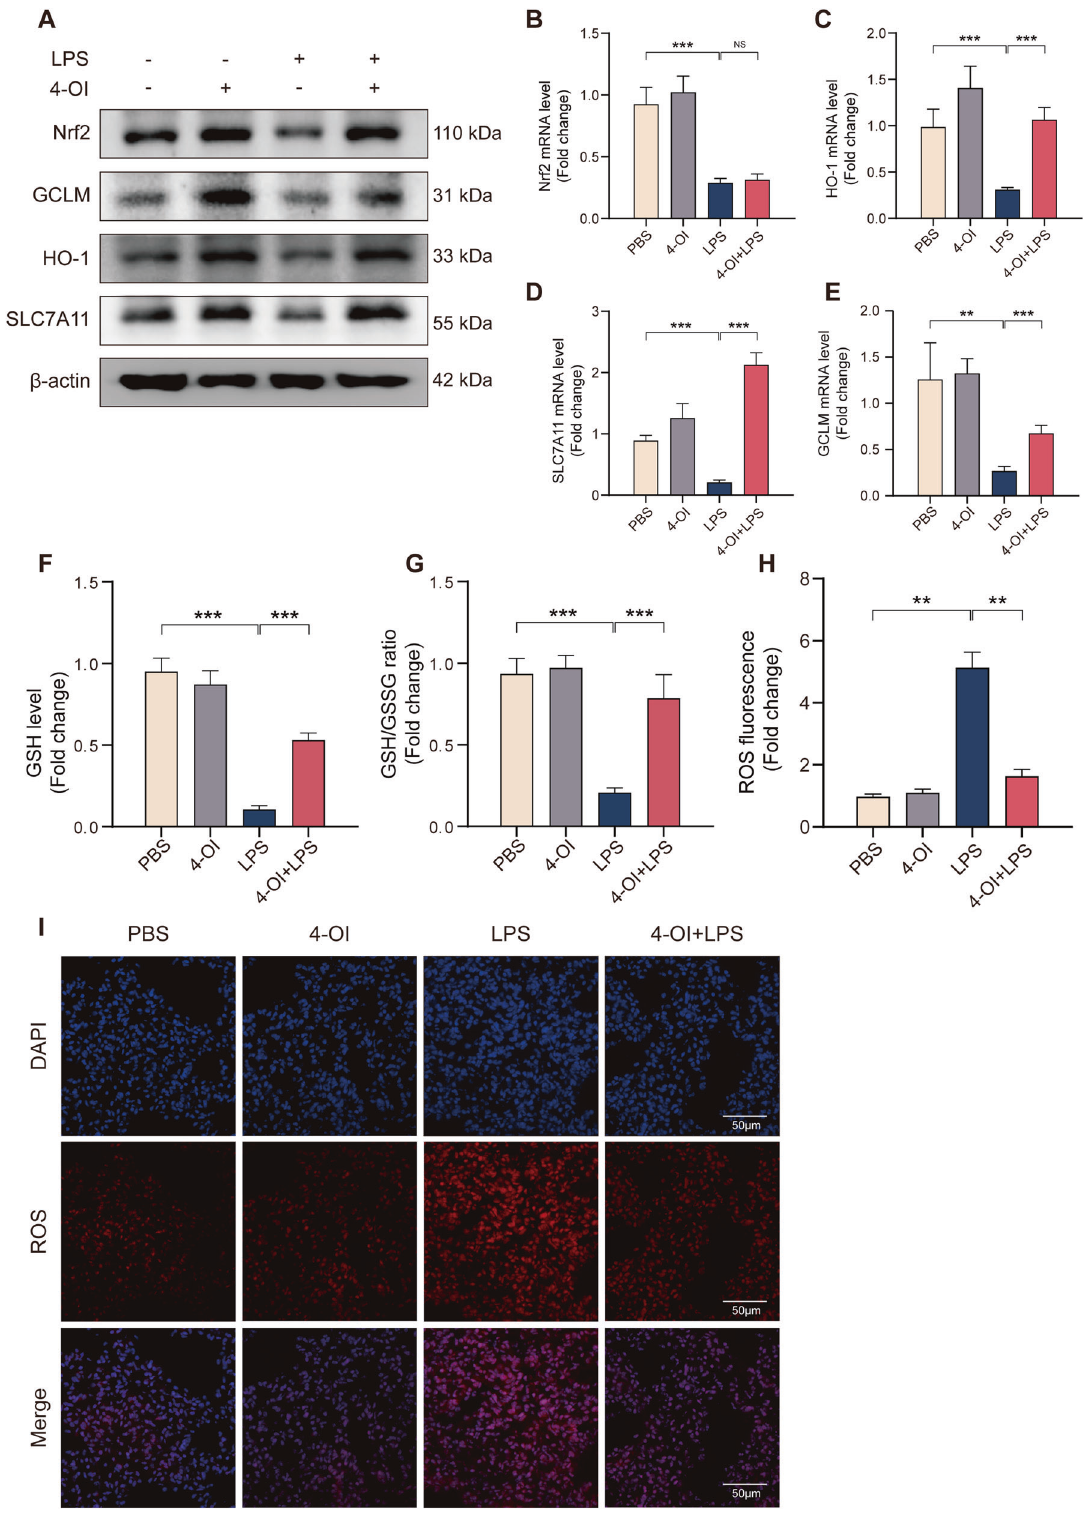
Fig. 3 4-OI inhibits ferroptosis through increasing and activating Nrf2 in vivo during ALI. A Western blots for Nrf2, GCLM, HO-1 and SLC7A11 in murine lung tissue. B – E Relative mRNA levels of Nrf2, GCLM, HO-1 and SLC7A11 in murine lung tissue ( n = 6). F , G Relative levels of GSH and GSH/GSSG ratio in murine lung tissue ( n = 6). H , I Representative images of fl uorescence probe for ROS and its statistical results ( n = 6) in lung tissue. (Data are presented as Mean ± SD * p < 0.05, ** p < 0.01, *** p < 0.001).